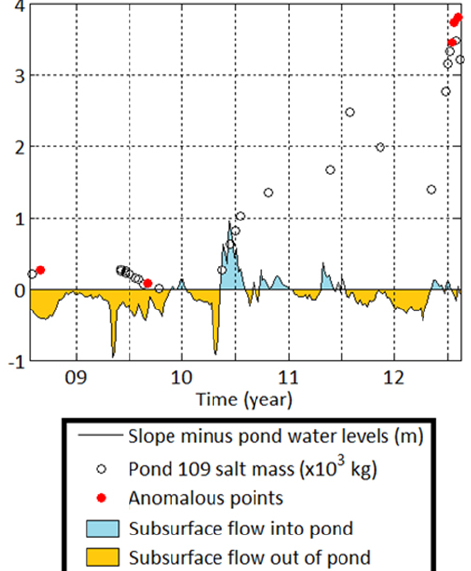
Fig. 7. (A) Water level differences between upland piezometer and pond 109 and M salt . Red symbols indicate the anomalous points, where a disparity was observed between the direction of the sub- surface water flows a the north end of pond 109 and the changes in M salt .